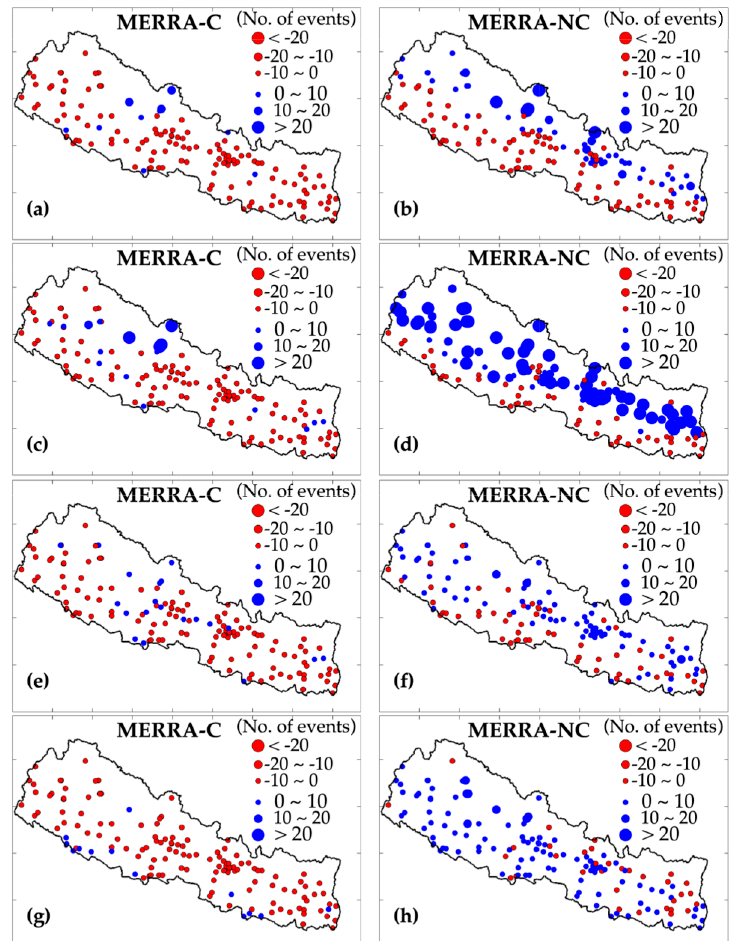
Figure 8. Spatial distribution of bias in very wet events (R95p) at each station for ( a , b ) pre-monsoon, ( c , d ) monsoon, ( e , f ) post-monsoon, ( g , h ) winter between observed and MERRA-2 datasets, respectively. Red and blue circles represent the underestimated and overestimated of R95p events across the country, respectively.